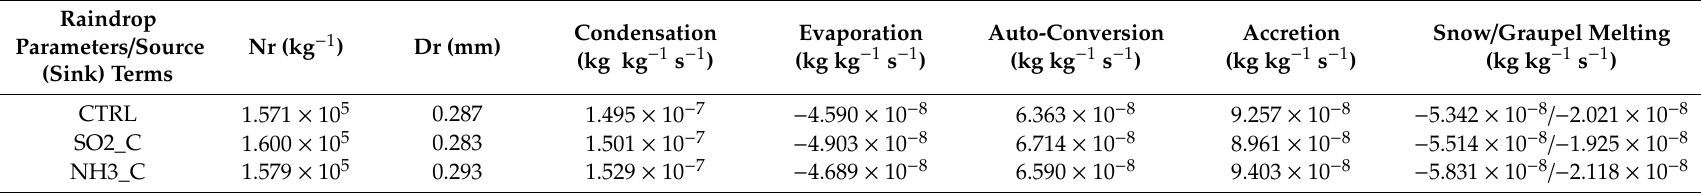
Table 2. Time-area averaged raindrop number concentration (Nr), mass-weighted diameter (Dr) and source / sink terms of raindrop mixing ratio in three runs. The data within the vortex from 0000 UTC to 0600 UTC 2 August are